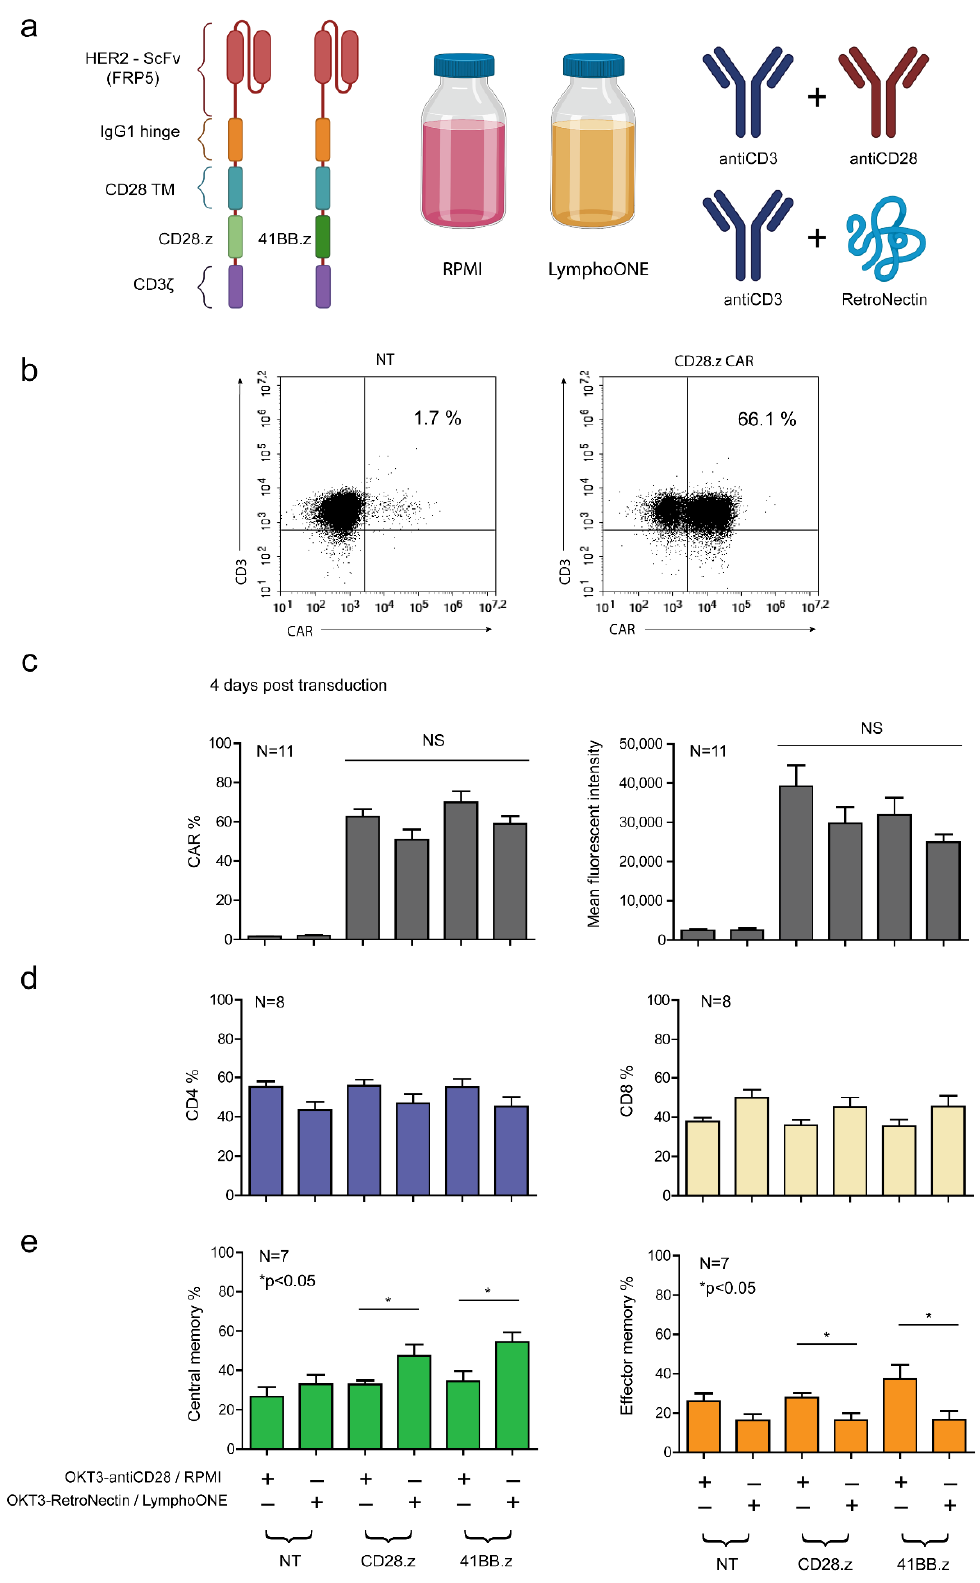
Figure 1. Generation of FRP5-derived HER2-CAR T cells with the two distinct cell culturing and two distinct stimulating methods, and assessing their distribution of CD4/CD8 and memory phenotypes. ( a ) Schematic diagram illustrating the modular composition of the CD28.z and 41BB.z HER2-CARs, the two media (RPMI and LymphoONE), and the two stimulation methods (antiCD3+antiCD28 and antiCD3+RetroNectin) applied in the experimental approach. ( b ) Representative flow cytometry dot-plot of CD28.z HER2-CAR T cells and non-transduced T cells. ( c ) HER2-CAR expression